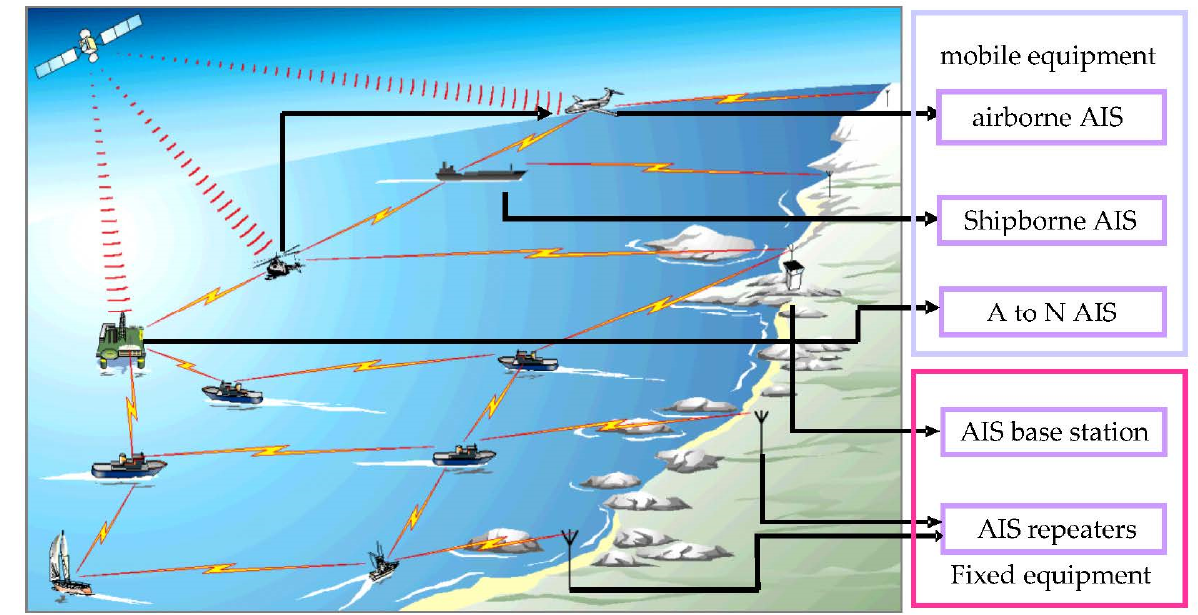
Figure 1. AIS communication link.